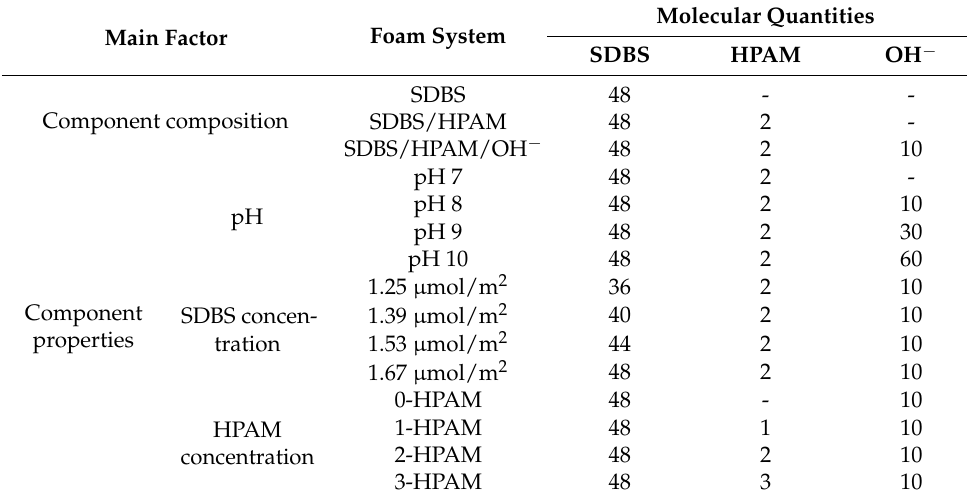
Table 1. Simulation scheme and molecular quantities in different foam systems.